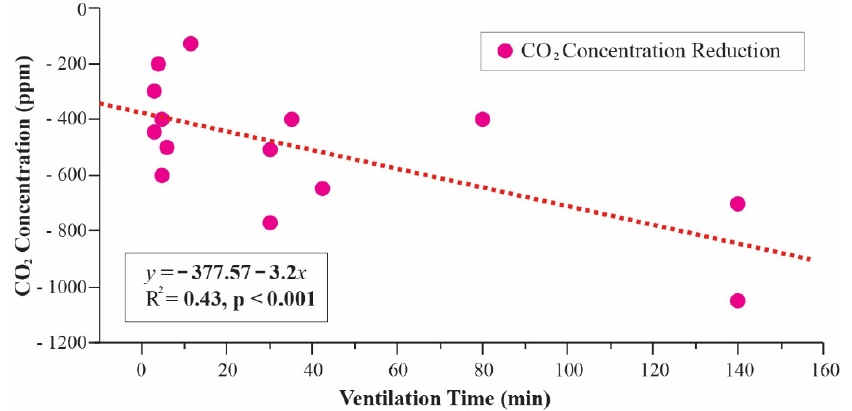
Figure 13. CO 2 concentration by ventilation time.